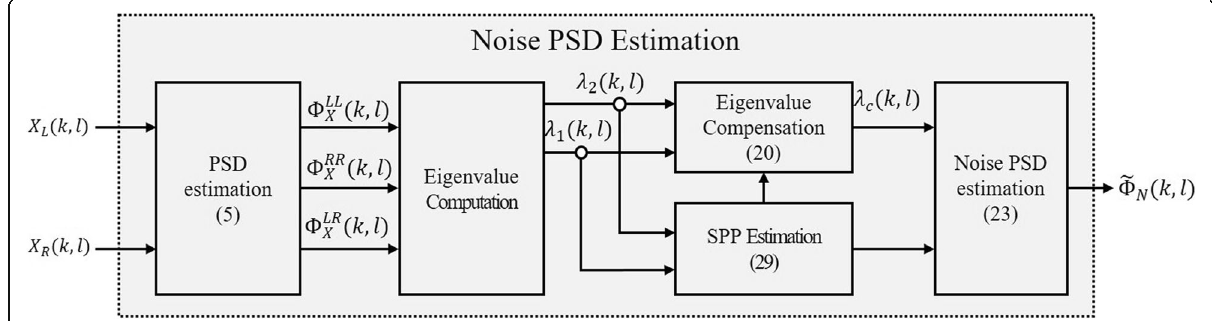
Fig. 2 Block diagram of the proposed noise PSD